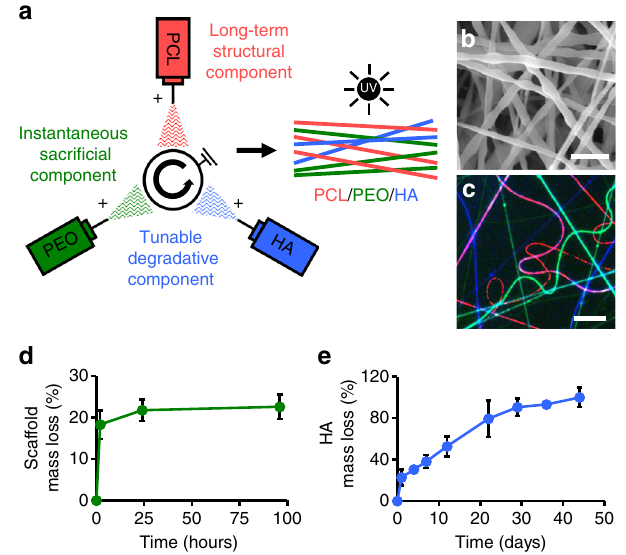
Fig. 2 Controlled fi ber degradation from tri-component nano fi brous scaffolds. a Electrospinning schematic with three independent fi ber jets collecting simultaneously on a common rotating mandrel. Discrete fi ber populations are composed of poly( ε -caprolactone) (PCL), poly(ethylene oxide) (PEO), and hyaluronic acid (HA). b SEM micrograph of PCL/PEO/ HA scaffold. Scale = 1 µ m. c Fluorescent image of randomly aligned PCL (red), PEO (green), and HA (blue) fi bers. Scale = 20 µ m. d Bulk scaffold mass loss (% of total) over 96 h ( n = 4 samples, mean ± s.d.). e HA mass loss (% of total, measured through uronic acid release) over 6 weeks ( n = 5 samples, mean ± imaging revealed that meniscus cell nuclei deformed and passed through 5 and 8 µ m pores, but could not pass through 3 µ m pores (Fig. 1b). In the absence of a PDGF-AB gradient (Control) there